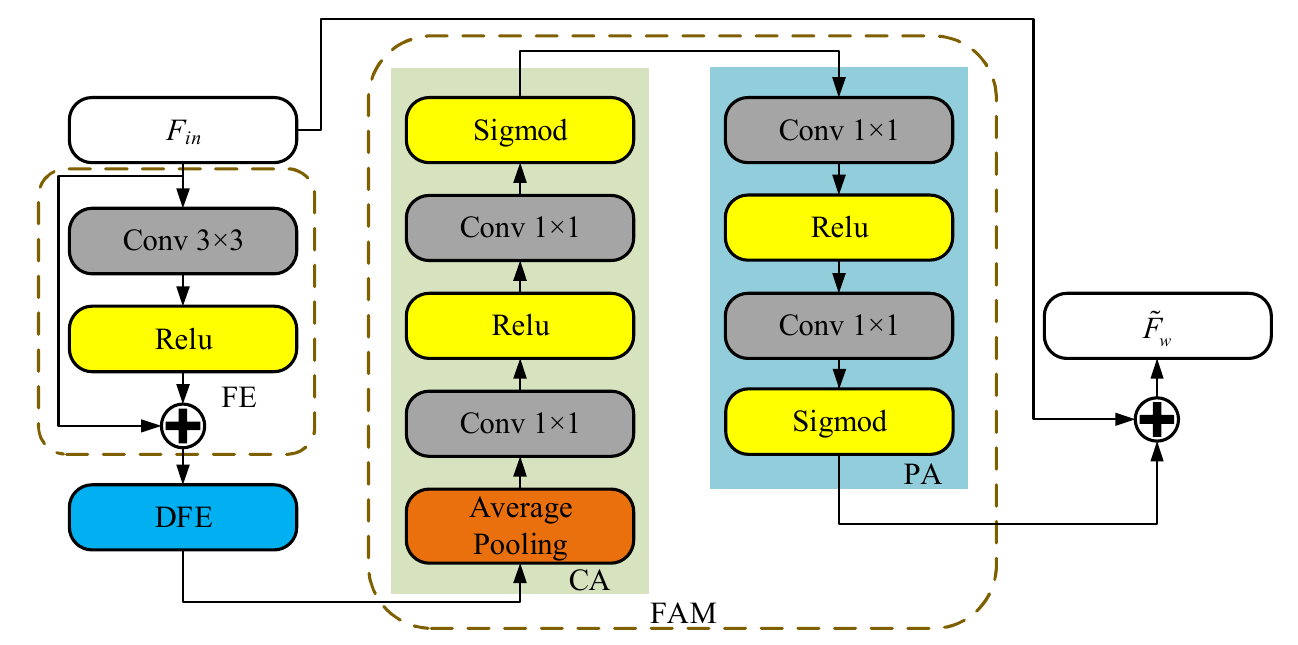
Figure 2. The proposed Dynamic Feature Attention module.